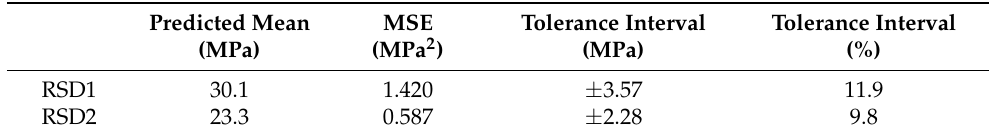
Table 14. Prediction accuracy of the two Response Surface Designs measured through the Tolerance interval